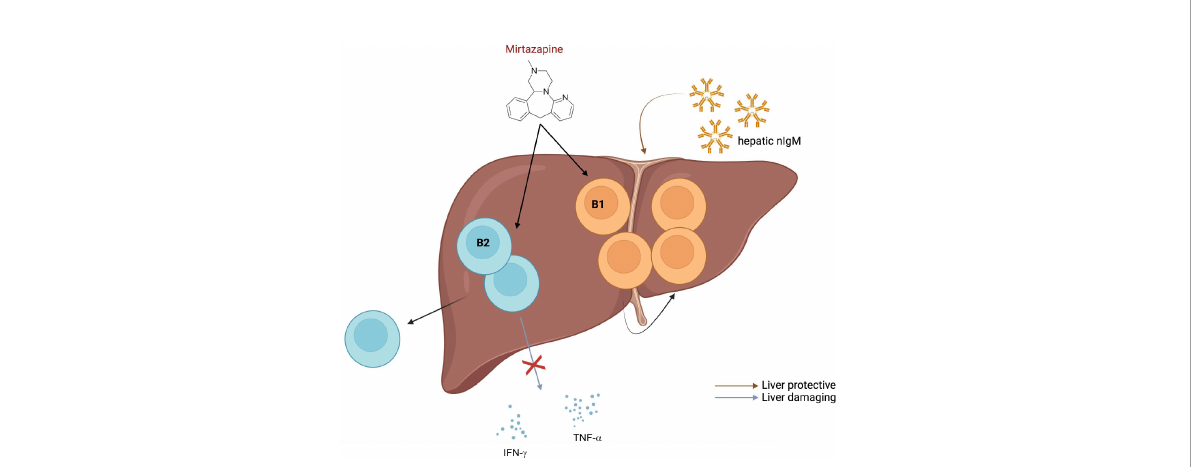
FIGURE 1 Possible effects of mirtazapine on liver-localized B cells. Almishri and colleagues (44) have demonstrated that treatment of mice with the atypical antidepressant, mirtazapine, leads to an increased proportion of hepatic B1 compared to B2 B cells, suppression of pro-in fl ammatory cytokine production by B cells and emigration of hepatic B2 B cells from the liver. Figure was created by using